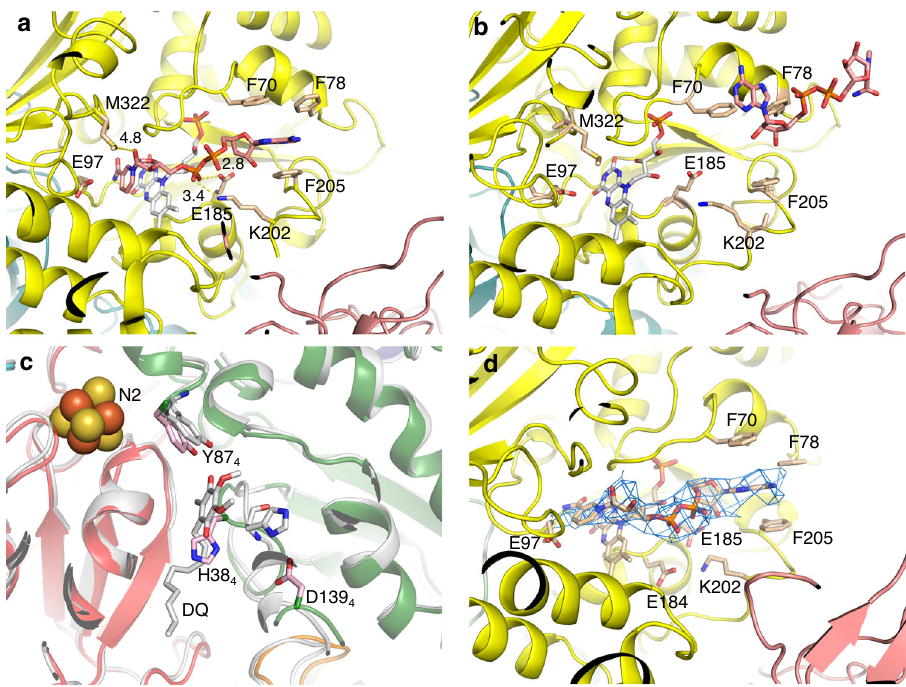
Fig. 2 NADH-binding site in complex I. a The main interactions of NADH with subunit Nqo1 (CXI NADH structure, after short soaking). FMN is coloured in white, NADH is in salmon. Key Nqo1 residues are labelled and the main NADH – protein interactions are indicated with yellow dashes, with distances in Å. b NADH binding out of its pocket after 5 h of soaking, ~15 Å away from FMN. c A structure obtained after overnight soaking with NADH shows a fl ip of H38 4 , key residue involved in the reduction of Q at the Q-site. The CXI DQ structure is overlaid and coloured in grey, illustrating potential clash of DQ with fl ipped H38 4 . d Cryo-EM map section demonstrating that NADH is bound to complex I in the CXI MJ :NADH